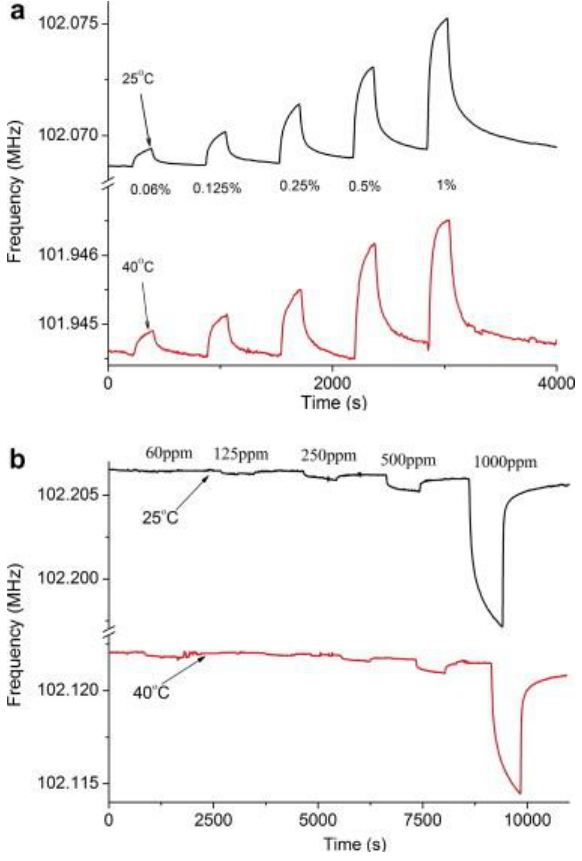
Figure 7. ( a ) Sensor response of graphene nanosheets integrated with LiTaO 3 SAW device on H 2 exposure showing an increase in frequency ( b ) Sensor response for CO showing drop in frequency, the measurements for both gases were carried out at 25 °C and 40 °C respectively. Adapted with permission from [105], copyright (2008) Elsevier.